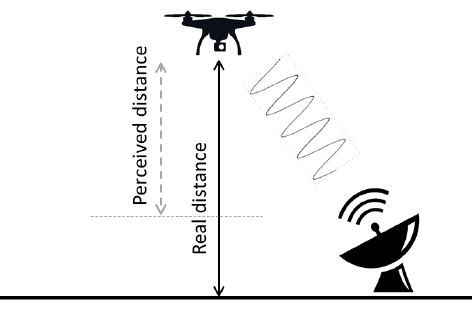
Figure 1. The proposed attack on the ultrasonic sensor using a continuous